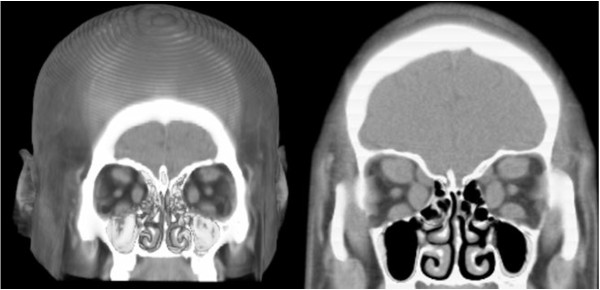
The thickening of extraocular muscles was evaluated on multislice CT with volumetric reconstruction of a coronal slice. Left: thickening is evident in the inferior, medial, and superior rectus muscles. Right: thickening of the four rectus muscles and SO.